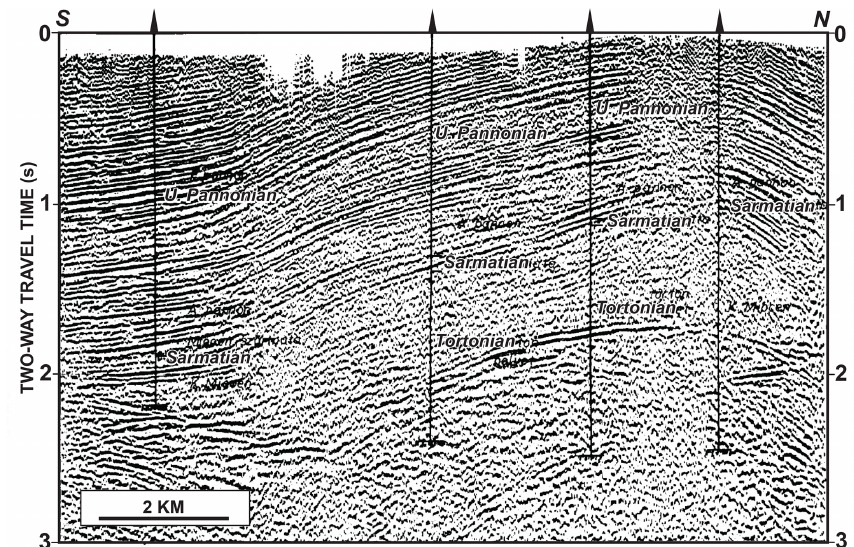
Figure 5. Vintage 2D reflection seismic illustration of the Budafa field (Dank, 1988; Pogácsás et al., 1994). The asymmetric nature of the surface anticline suggests an underlying master fault on the northern flank of the structure. Even on this moderate- to poor-quality vintage line one can interpret the thickening of the upper–middle Miocene (“Pannonian–Sarmatian–Tortonian”) strata beneath the apex of the anticline. This provides evidence for the latest Pliocene to Quaternary inversion of a preexisting Miocene syn-rift half-graben. Unfortunately, the seismic data quality is not good enough to properly delineate the position of the master fault, let alone that of the null point.